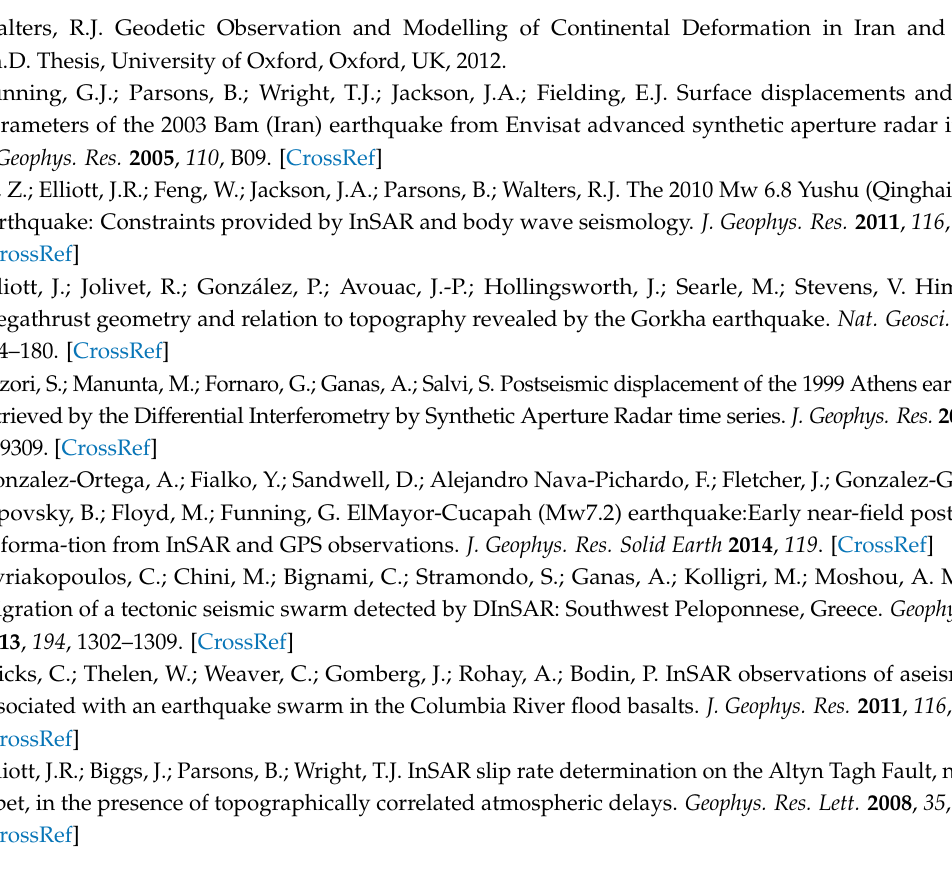
Figure S1: spatial and temporal baseline plot of 34 Envisat SAR acquisitions for the descending track 18 covering the eastern part of the Haiyuan fault, Figure S2: 3D and planar geometry for InSAR observation, Figure S3: comparison of wet delay maps from MERIS and ECMWF for 4 largely cloud-free acquisitions, Figure S4: the results for the regional discretization, Figure S5: the fine horizontal velocity field inverted jointly by InSAR and GPS for the northeastern margin of the Tibetan Plateau. Figure S6: Regional seismicity map with 19 moderate earthquake since 1986, and Figure S7: The GPS velocity field from Gan et al. for the northeastern margin of the Tibetan